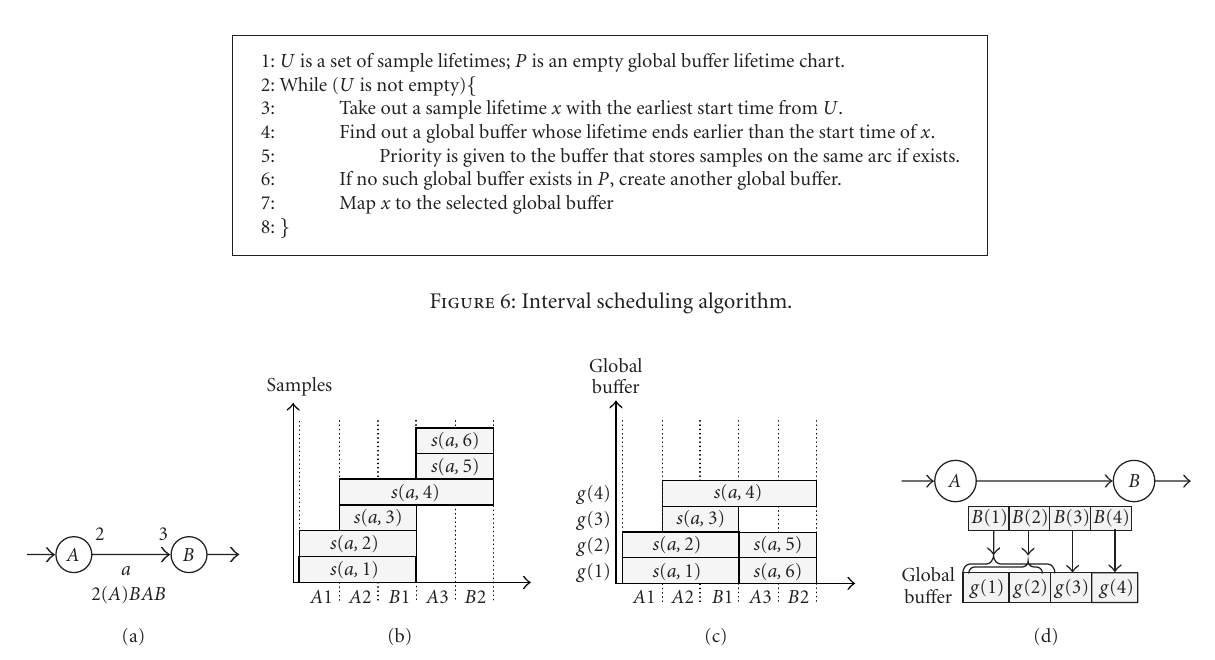
Figure 7: (a) An SDF subgraph with a given schedule, (b) the sample lifetime chart, (c) the global bu ff er lifetime chart, and (d) local bu ff er allocation and